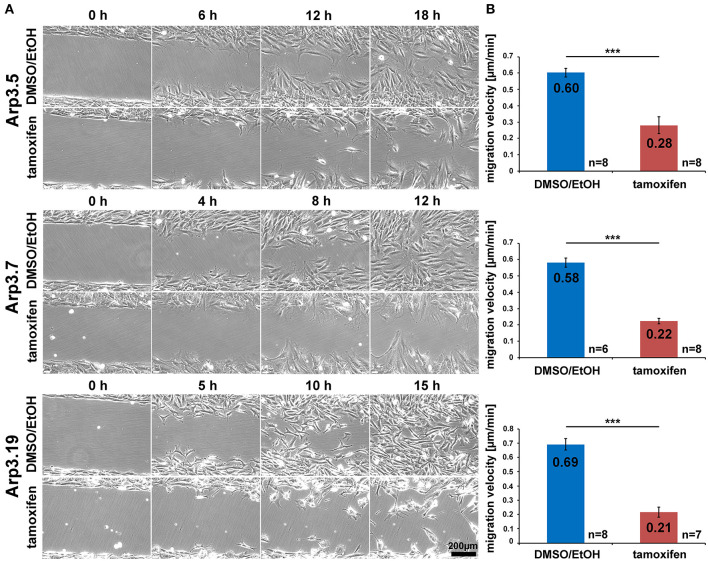
Acute Arp2/3 complex removal reduces wound closure capacity. (A) Selected frames from wound healing, time-lapse microscopy (24 h) of control- and tamoxifen-treated Actr3fl/fl clones. Wounds closed on average after roughly 18 h in controls, but failed to do so in Arp3 null cells. (B) Quantification of collective migration velocity during wound closure utilizing movies as displayed in (A). Bar charts show arithmetic means and SEMs. n = number of movies analyzed, generated from three independent experiments. Differences in wound closure speed between individual control- and tamoxifen-treated clones were confirmed to be statistically significant using two-sided two-sample t-test (***p < 0.001).